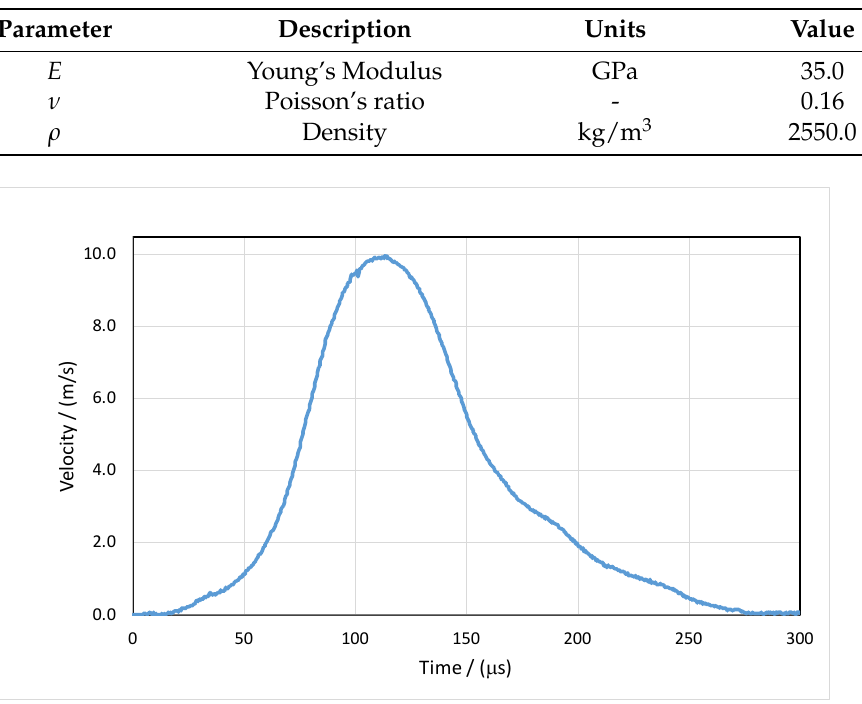
Figure 1. Generic setup of a SHPB experiment. Table 1. Elastic properties and density for granite.